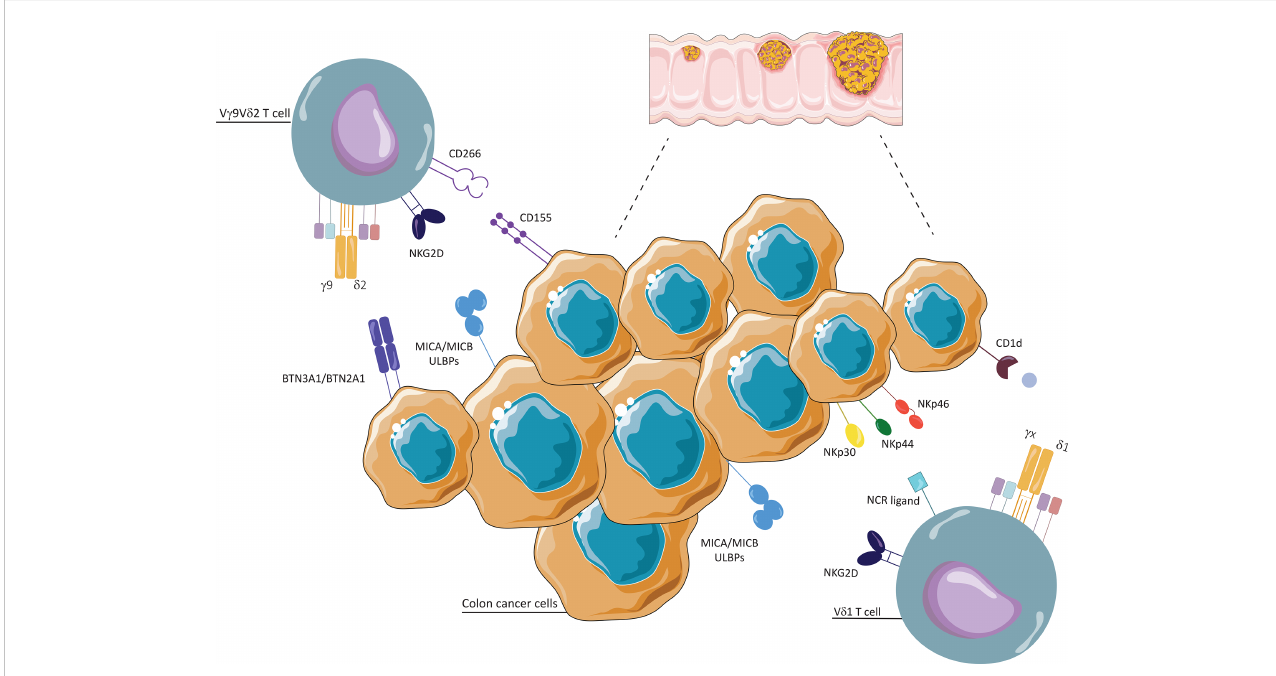
FIGURE 1 Interaction between gd T cells and colon cancer cells. V d 1 and V d 2 T cells conduct cytotoxic activities thanks to their ability to recognize stress antigens expressed by transformed cells, such as MHC class I-related molecules A and B (MICA/MICB) and UL16-binding proteins (ULBPs), via NKG2D receptor. V d 1 T cells recognize self-glycolipids presented by CD1c and CD1d, and tumor cells through natural cytotoxicity receptors (NKp30, NKp44, NKp46). V d 2 T cells recognize and respond to phosphoantigens (P-Ags), through unrestricted MHC manner, with two types I glycoproteins of the B7 family, butyrophilin (BTN)2A1 and BTN3A1. They interact with tumor cells through CD226 (DNAM-1)/CD155 (Nectin-2).